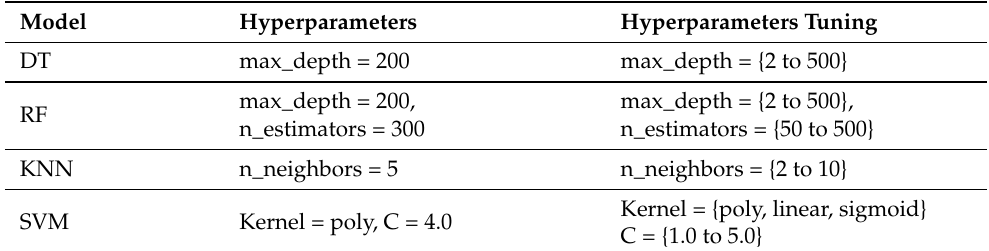
Table 7. Hyperparameters setting for machine learning